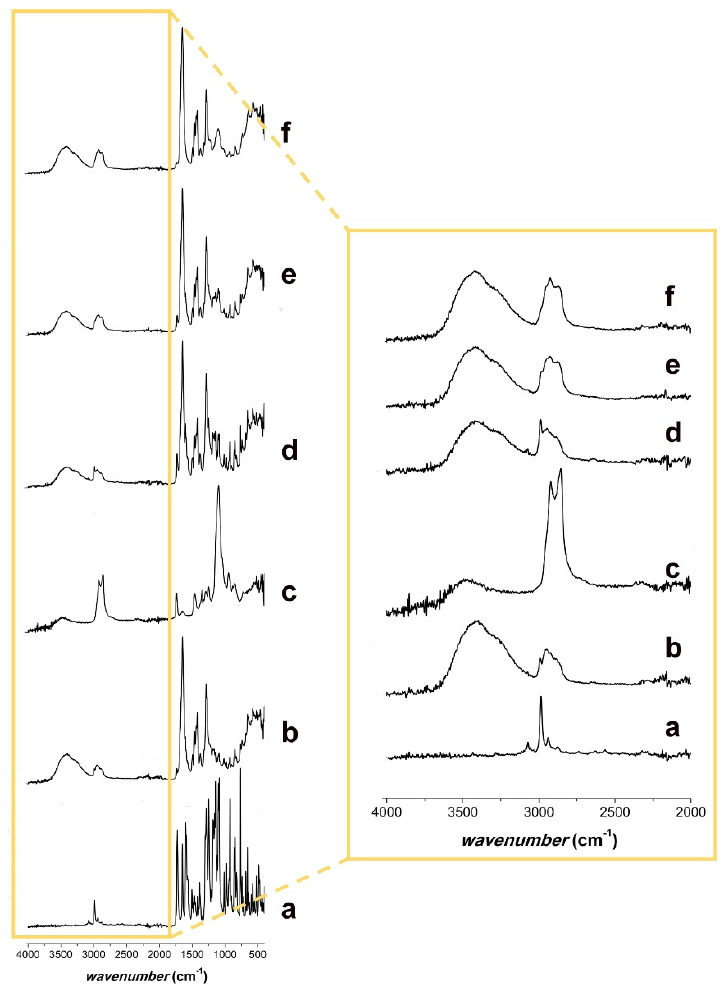
Figure 5. ATR-FTIR spectra of ( a ) FEN; ( b ) PVP K29/32; ( c ) polysorbate 80; ( d ) physical mixture of FEN and PVP K29/32; ( e ) physical mixture of FEN, PVP K29/32, and polysorbate 80; and ( f ) FEN-loaded microfibers.